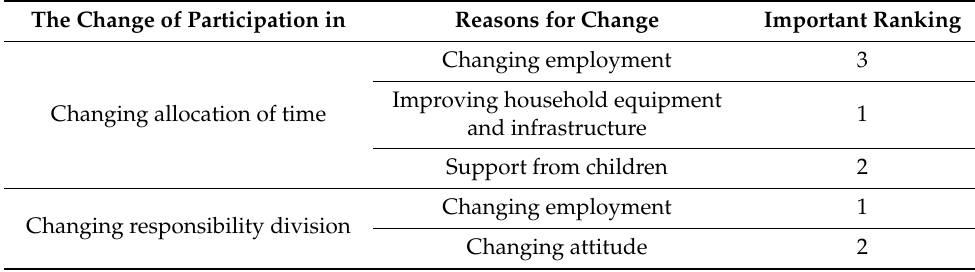
Table 6. The reasons for changing allocation of time and dividing responsibilities in unpaid care